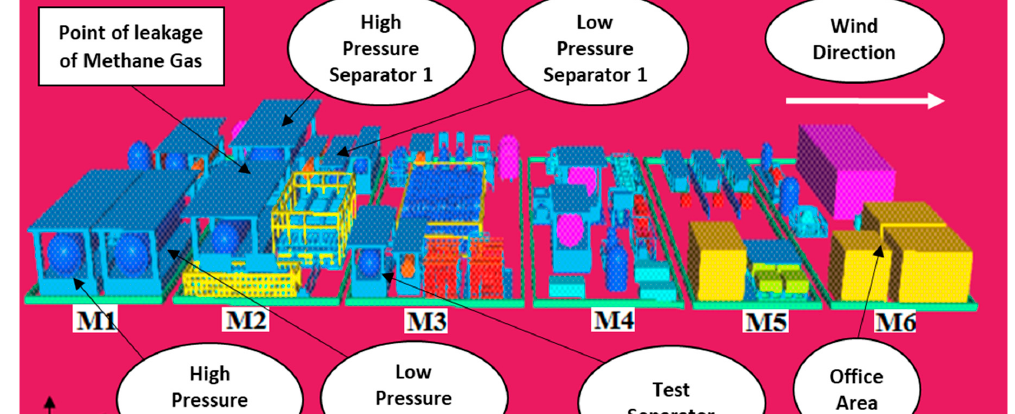
Process Safety Progress; published by Wiley, 2020.